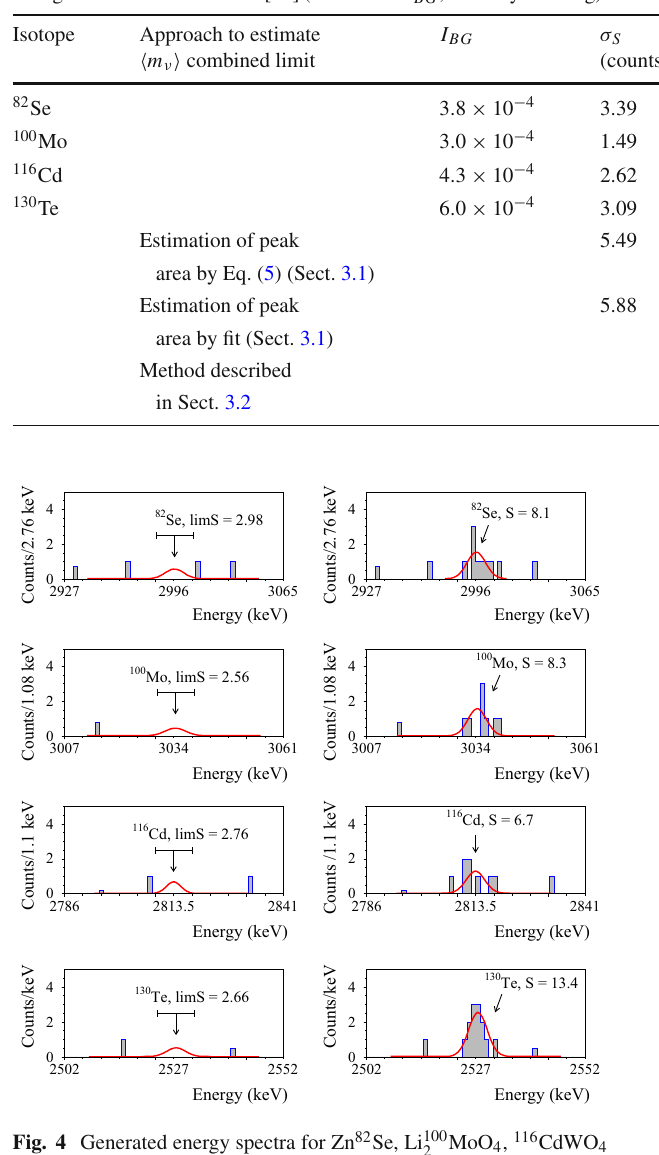
The errors σ (cid:2) m ν (cid:3) 2 and the neutrino mass limits were calculated by using the matrix elements from Ref. [46], the phase space factors from Ref. [47] and the value of the axial vector coupling constant g A = 1 . 27